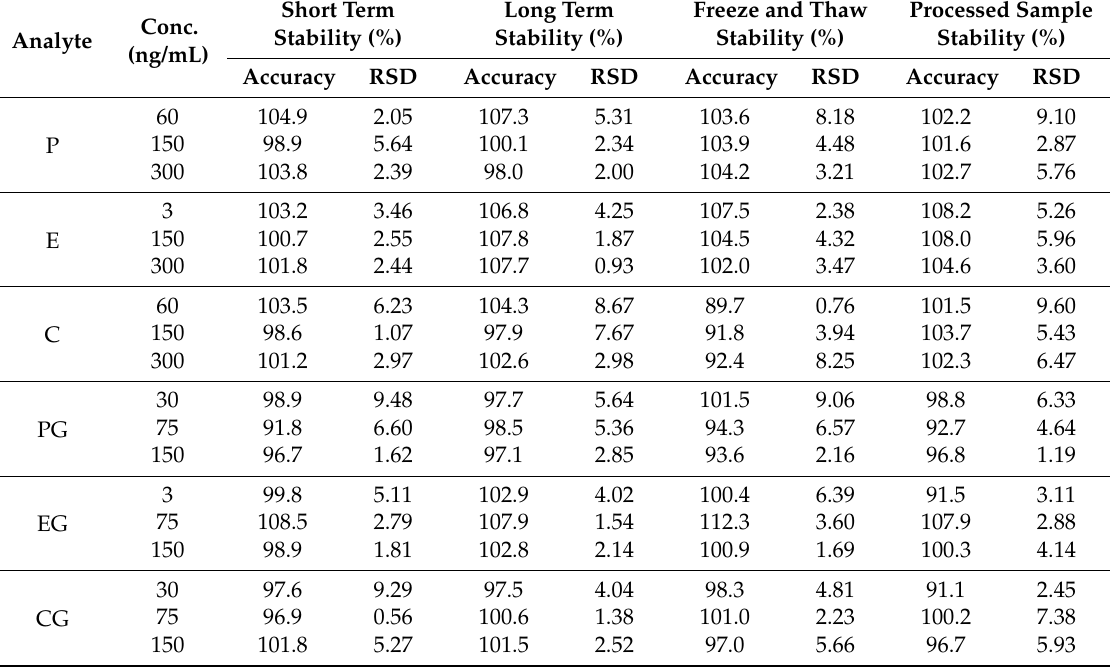
Table 4. Stability of anthraquinones in rat plasma ( n = 3).